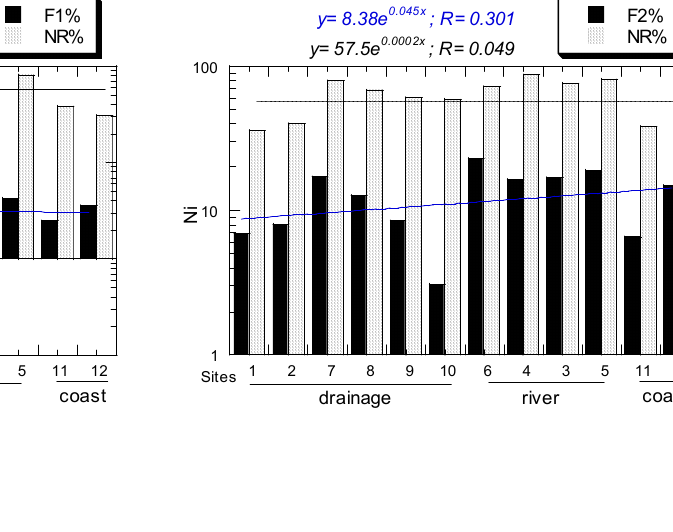
fractions (NR/R; unitless), enrichment factor (EF; unitless), geoaccumulation index (I geo ; unitless), contamination factor (CF; unitless), total Cu concentrations (Total Cu; mg/kg dry weight), and ecological risk (ER; unitless) of Cu. Note: hyphen (-) means minus.